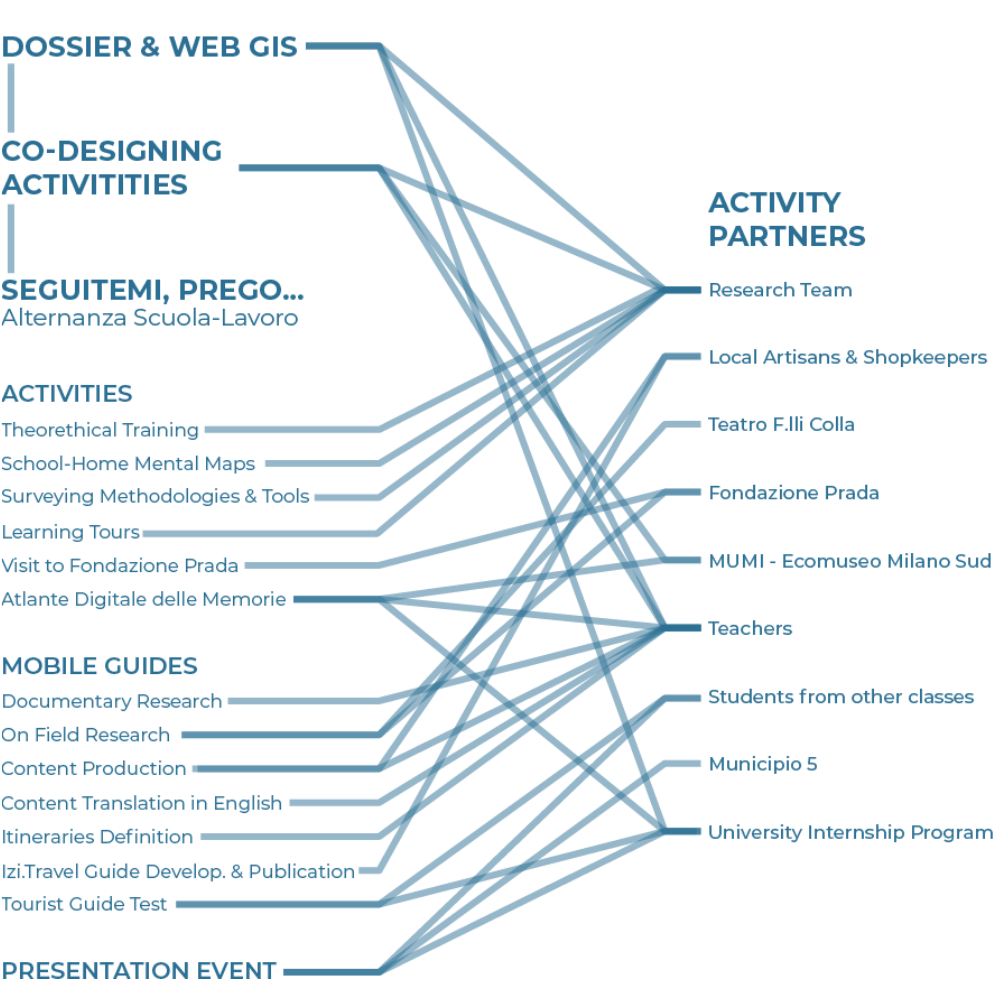
Fig. 2 Map of Seguitemi,